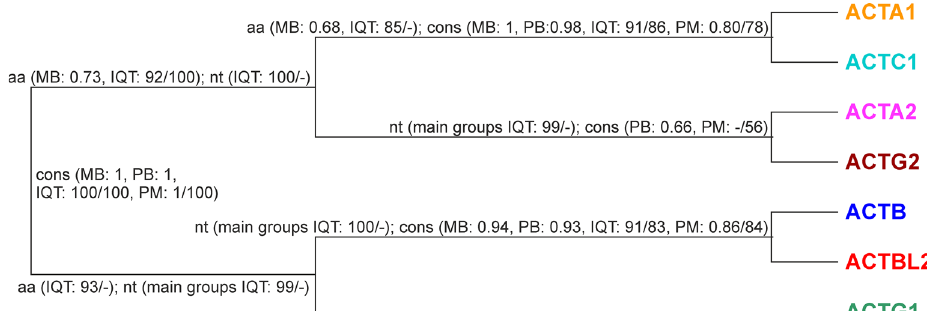
Figure 4. The most probable actin tree topology with support values obtained for various data sets: consensus sequences (cons), the full alignment of 1441 amino acid sequences (aa) and 3554 nucleotide sequences (nt), and by various software: IQ-TREE (IQT), morePhyML (PM), MrBayes (MB) and PhyloBayes (PB). Numbers at nodes for MB and PB correspond to posterior probabilities, whereas for IQT and PM to support values calculated by aLRT based on a Shimodaira-Hasegawa-like procedure (before the slash) and bootstrap analysis (after the slash). The support values lower than 50 are indicated by a dash “–”. The only clade in a competitive topology grouping ACTBL2 with ACTG1 was poorly supported in IQT tree: